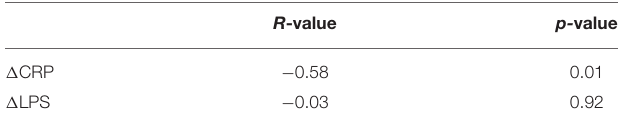
DatawereanalyzedbythePearsoncorrelationbetweenzFCand 1 inflammatorymarkers. 1 CRP = CRP (T 1 ) – CRP (T 0 ), 1 LPS = LPS (T 1 ) – LPS (T 0 ). The zFC was calculated by the Fisher’s Z transformation. CRP, C-reactive protein; LPS, lipopolysaccharide; T 0 , 1 day before surgery; T 1 , 24h after surgery. p < 0.05 was considered as statistically significant.